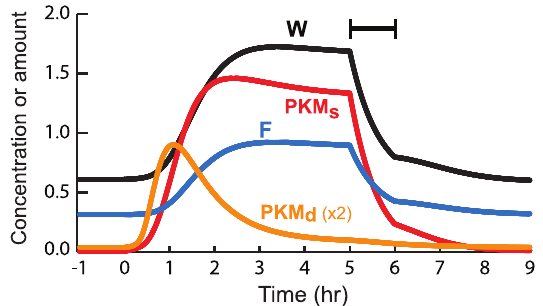
Figure 3. Simulated block of LTP maintenance by temporary inhibition of PKM.